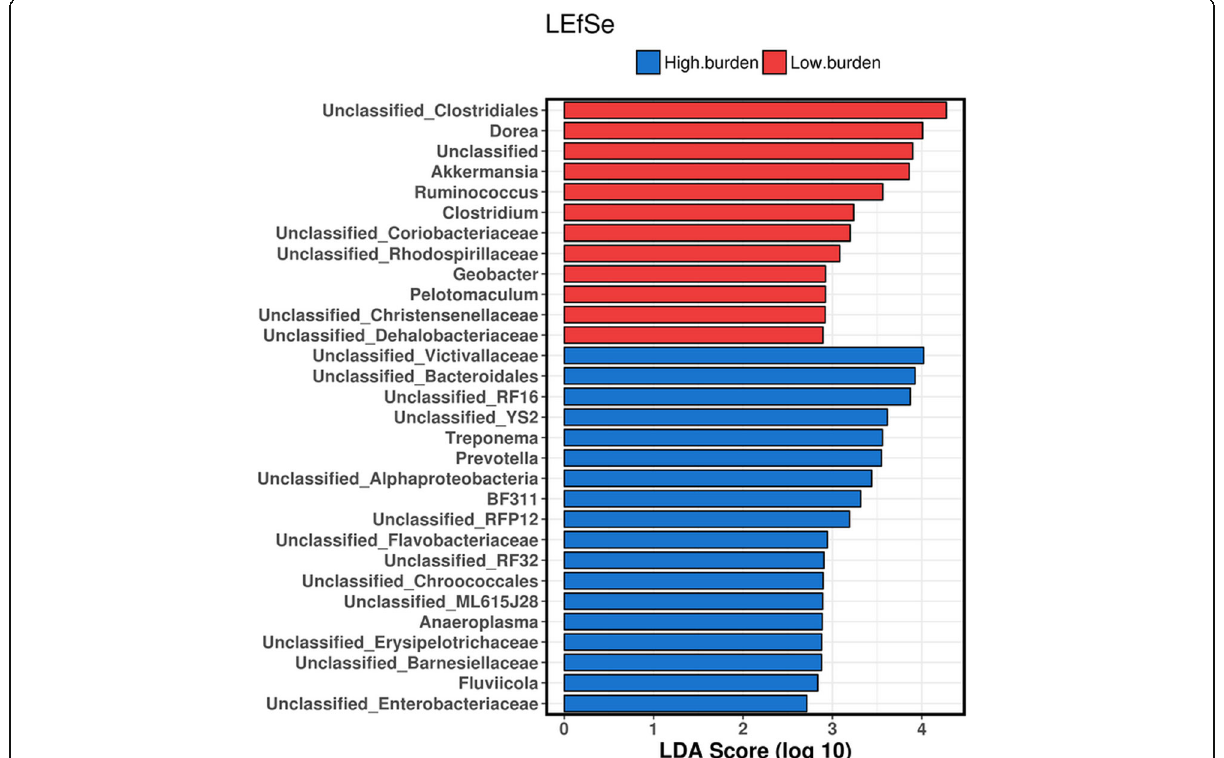
Fig. 4 Genera with absolute LDA score ≥ 2.0. Taxa (genus) associated with the differences between high and low burden sheep (before infection) were identified using